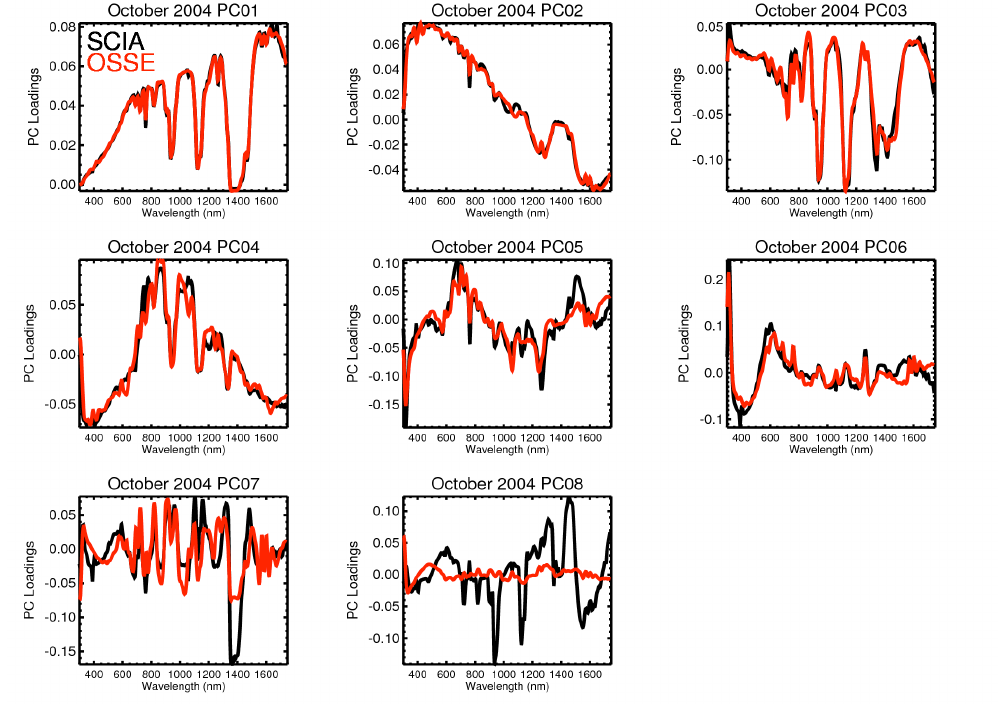
Fig. 9. The spectral shapes of the transformed eigenvectors for October 2004 in the shared intersection space. The first six or seven dimensions align well, and the first four dimensions share spectral characteristics with the first four original October 2004 PCs, shown in Fig.